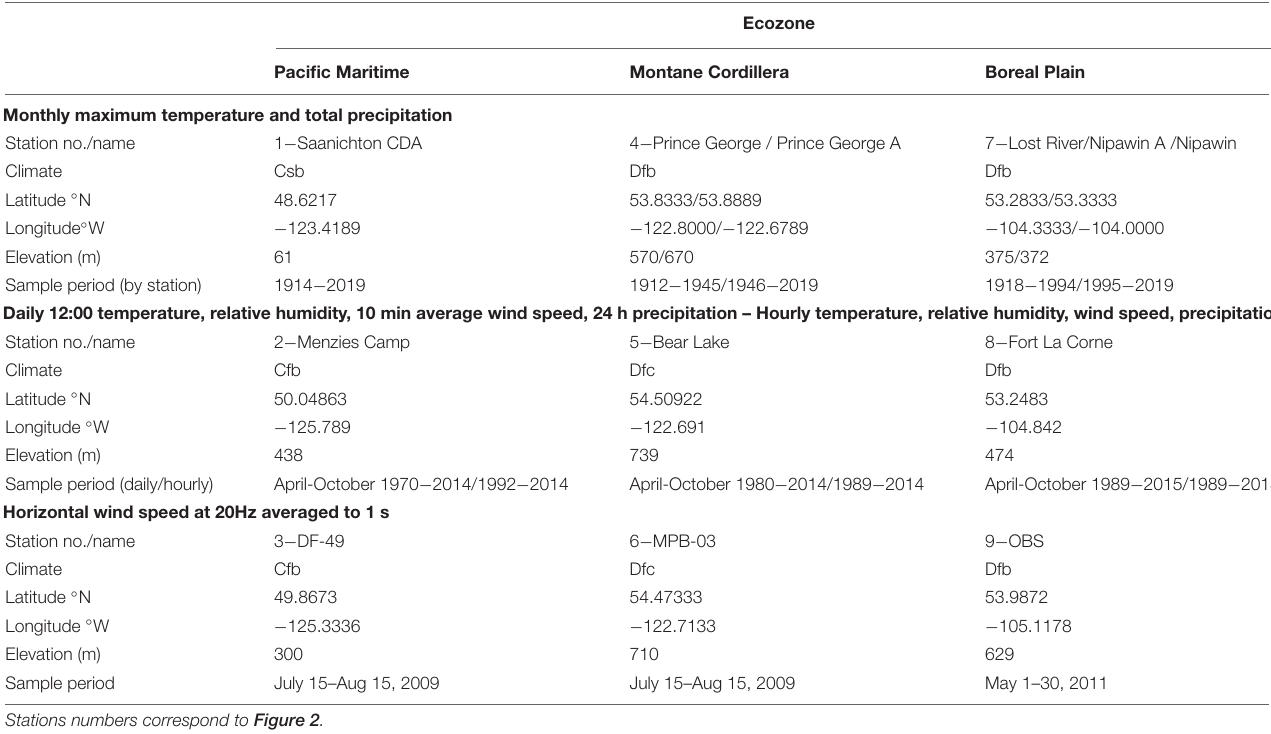
TABLE 3 | Station locations and sample periods for monthly, daily, hourly, and 1 s weather/climate observations in three ecozones in western Canada. Ecozone Pacific Maritime Montane Cordillera Boreal Plain